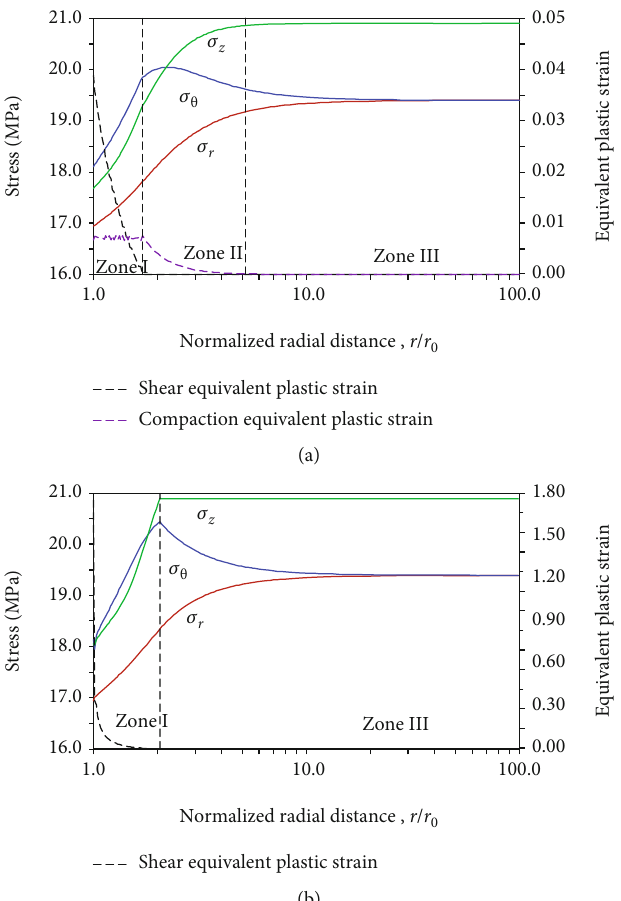
Figure 7: Distributions of the radial stress, hoop stress, and vertical stress, as well as the equivalent plastic strains along the radial direction: (a) with compaction and (b) without compaction (perfect fl ow barrier and p m of